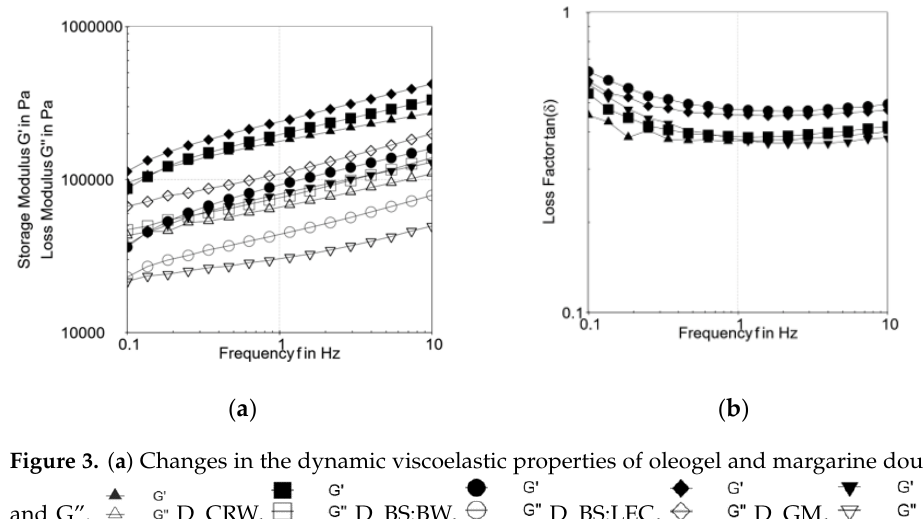
Figure 3. ( a ) Changes in the dynamic viscoelastic properties of oleogel and margarine doughs: G’ and G ” . D_CRW, D_BS:BW, D_BS:LEC, D_GM, D_MR. ( b ) Changes in the dynamic viscoelastic properties of oleogel and margarine doughs: tan δ. D_CRW, D_BS:BW, D_BS:LEC, D_GM, D_MR. Table 2. Textural properties and color parameters of dough samples.